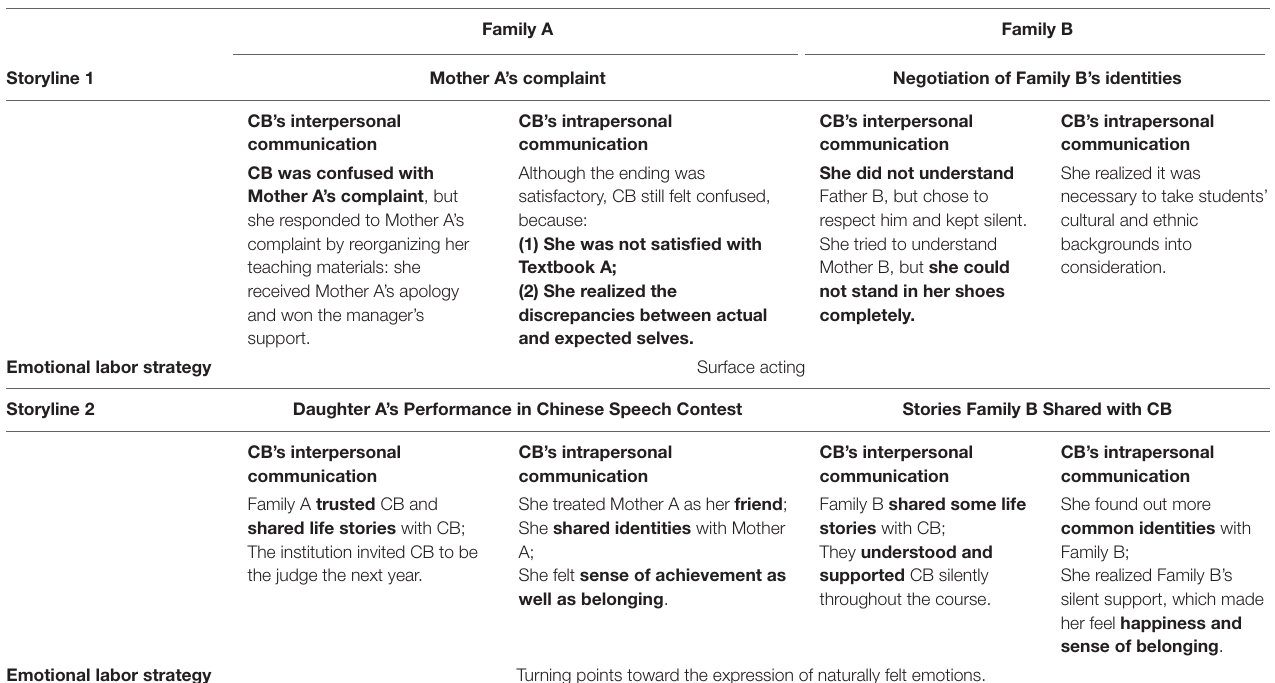
TABLE 3 | Summary of